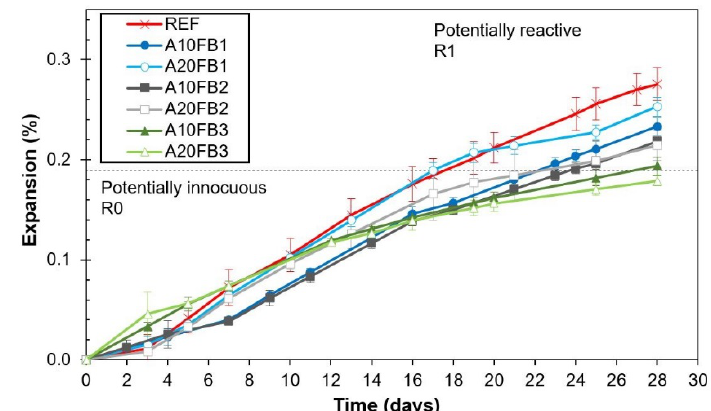
Figure 5. Expansion of the mortars, containing the fine of origin B, during the accelerated test for evaluation of the alkali- aggregate reaction (AAR) and the classification